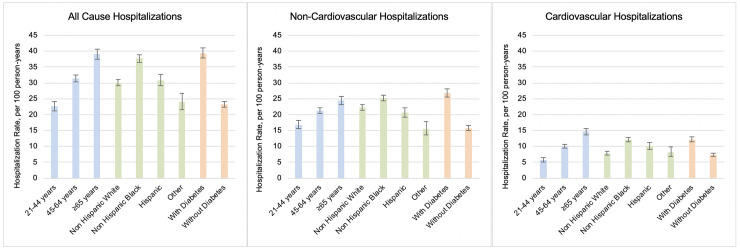
Age-, race-, and diabetes-adjusted rates for all-cause, non-cardiovascular, and cardiovascular hospitalizations in CRIC participants (N = 3,939).Rates reported as per 100 PY. Error bars indicate 95% confidence intervals. CRIC, Chronic Renal Insufficiency Cohort; PY, person-years.